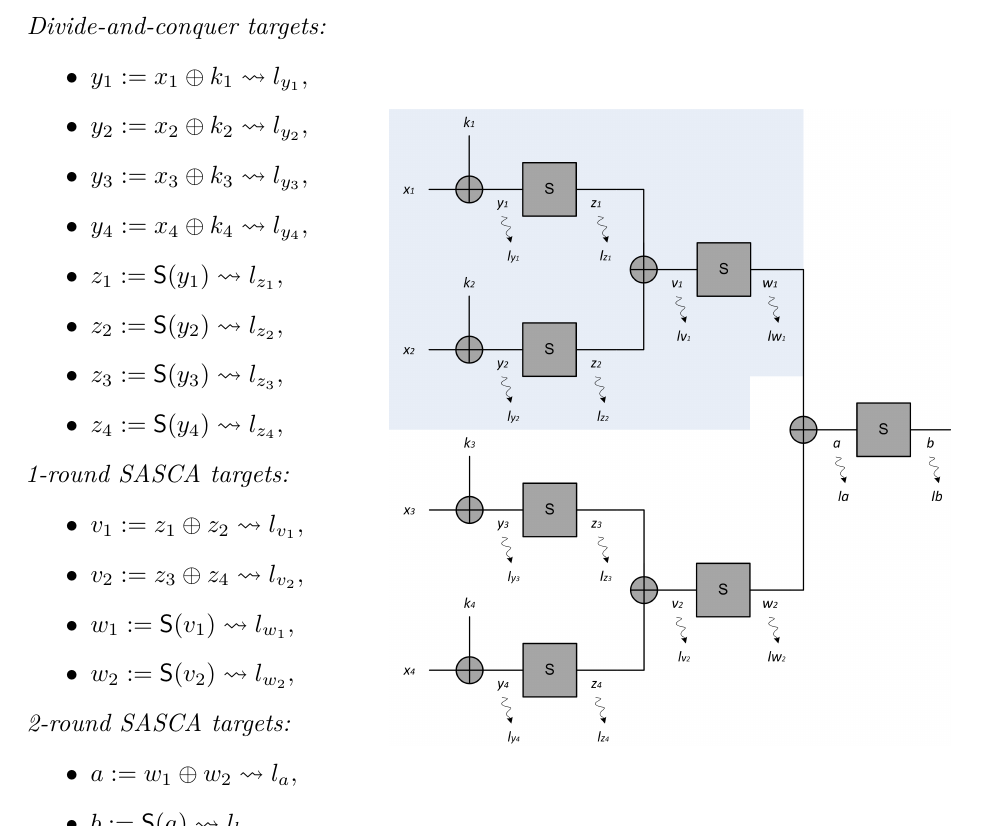
Figure 1: Toy unprotected